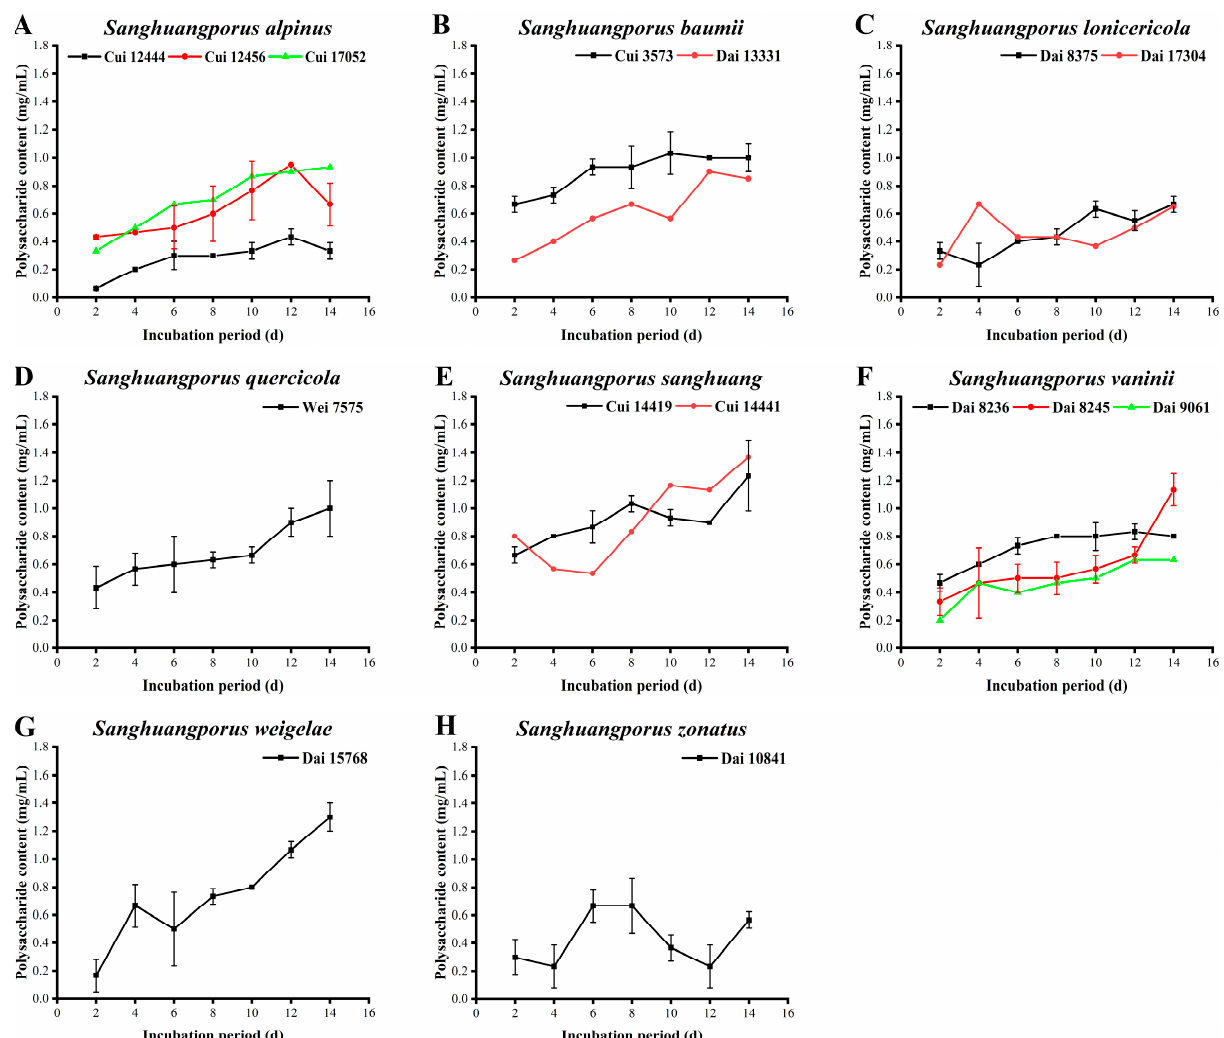
Figure 2. Variations in polysaccharide contents during submerged fermentation of 15 wild strains from 8 species of Sanghuangporus . ( A ) Sanghuangporus alpinus Cui 12444, Cui 12456, and Cui 17052.